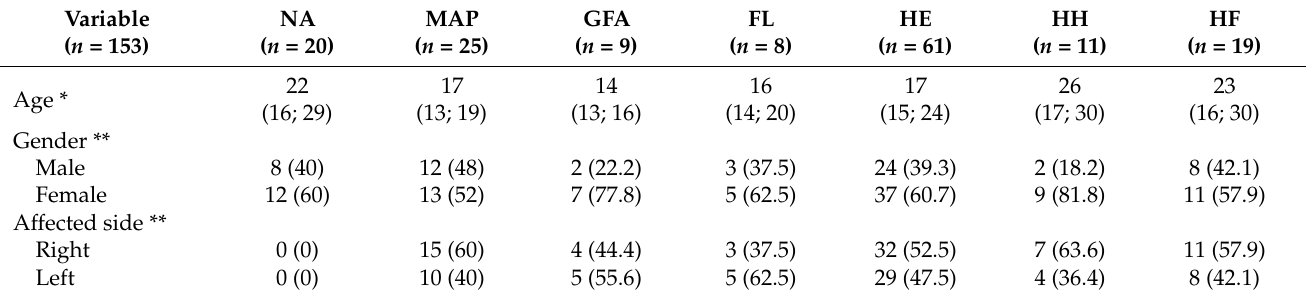
Table 3. Demographic and clinical description of the patients with FA and subjects without FA or signs of TMD.